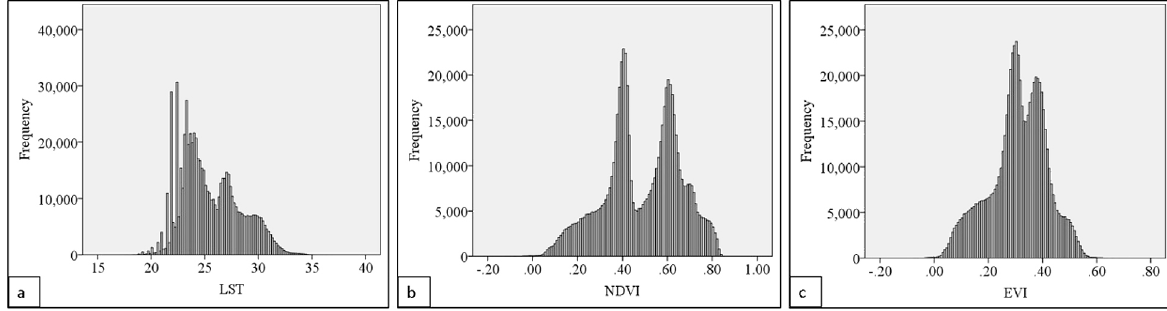
Fig. 3. Histograms showing a range of values from 1984 to 2019 for LST (a), NDVI (b), and EVI